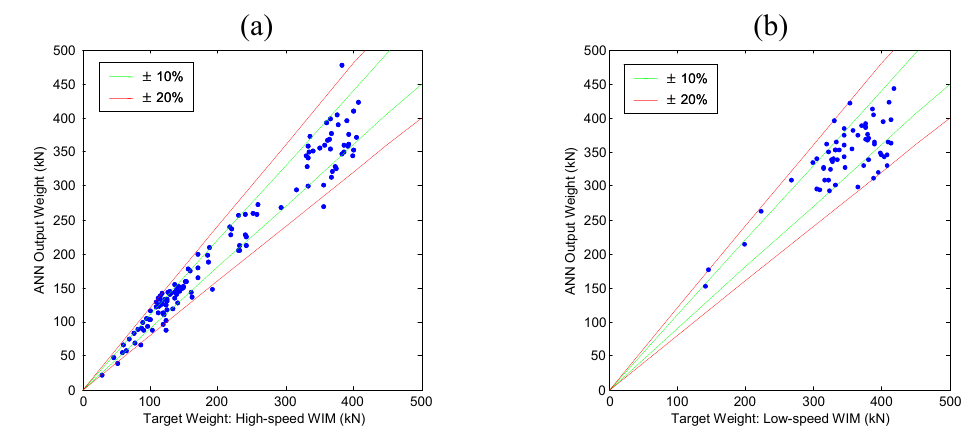
Figure 9. Results of validation test of (a) Geumdang Bridge — cross beam strain. (b) Seohae Bridge — north bound 3 rd lane.